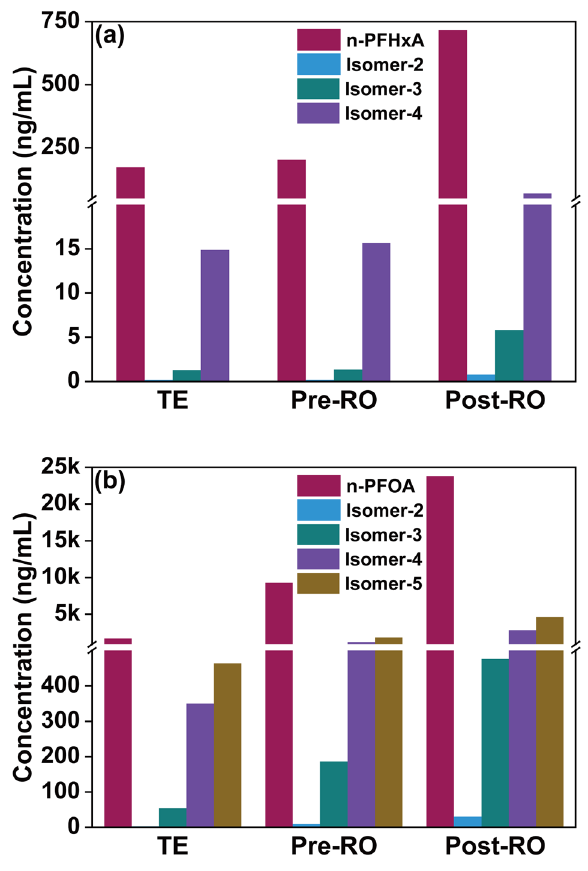
Fig. 4 Isomeric concentration distributions of two typical PFASs detected in the wastewater samples. a Per fl uorohexanoic acid (PFHxA). b Per fl uorooctanoic acid